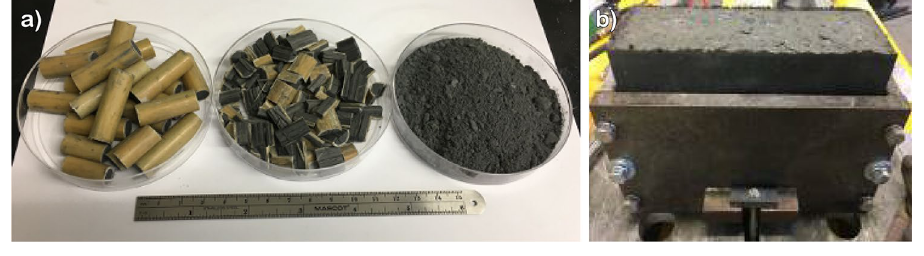
Fig. 5 a , b. Steel high-pressure compaction rectangular mold used in the dynamic compac- tion system after compaction a and after extraction